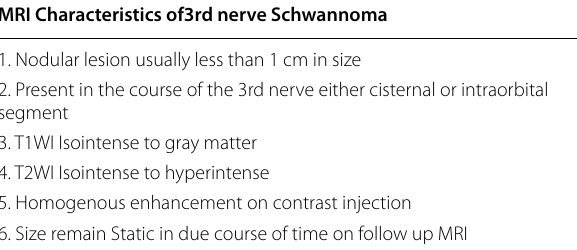
Table 1 Radiological findings in oculomotor schwannoma MRI Characteristics of3rd nerve